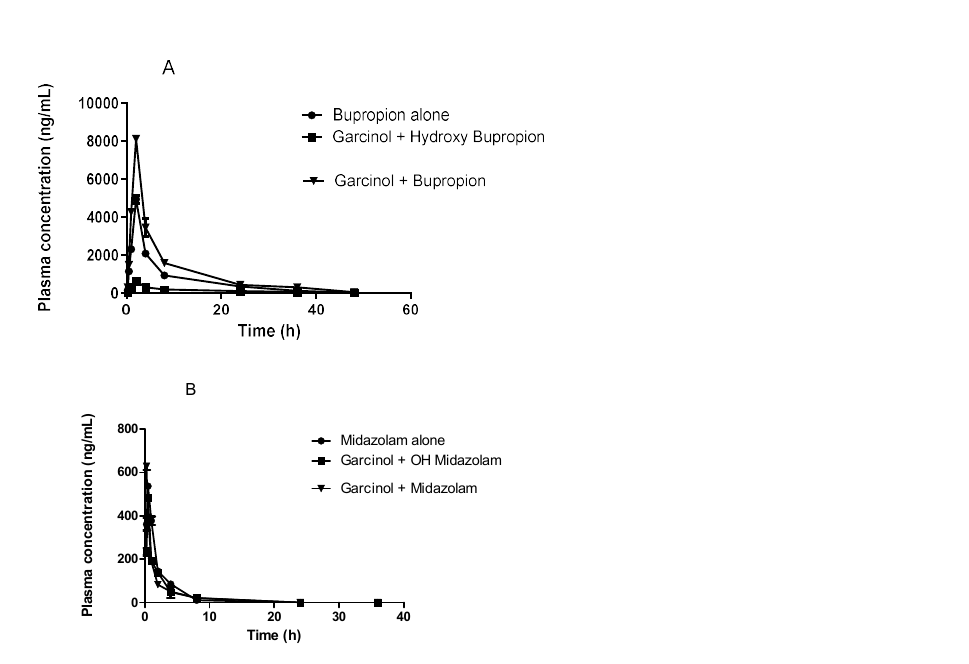
Figure 2. Mean plasma concentrations of bupropion ( A ) and midazolam ( B ) after oral administration of garcinol at a dose of 25 mg/kg in rats. 3.4. Expression of P-gp by Garcinol in Rat Brain and Intestinal Tissues Rat brain and intestinal tissue homogenates were used to evaluate the potential of garcinol to alter the expression of P-gp in-vivo. There was a significant difference in the expression in brain and intestinal tissues between two groups, as shown in Figure 3A. P-gp expression was increased by 1.62 and 1.07 fold, respectively, in the brain and intestinal tissues between the control group and the garcinol-treated group ( p < 0.05), as shown in Figure 3B.